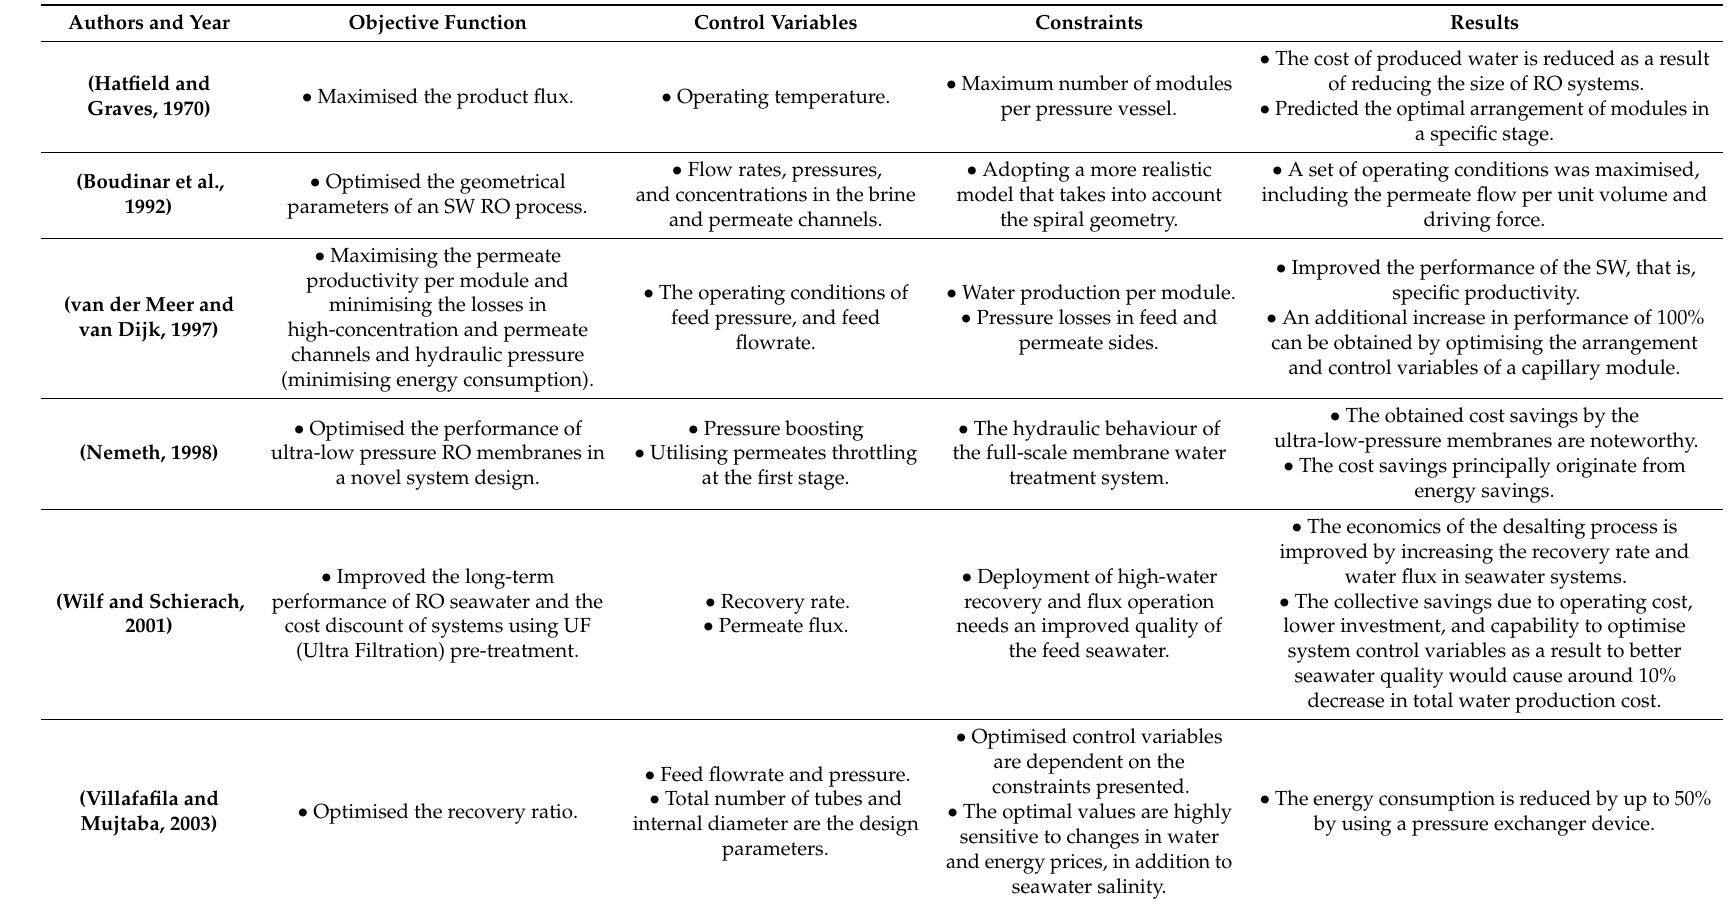
Table 3. Summary of the past work of RO